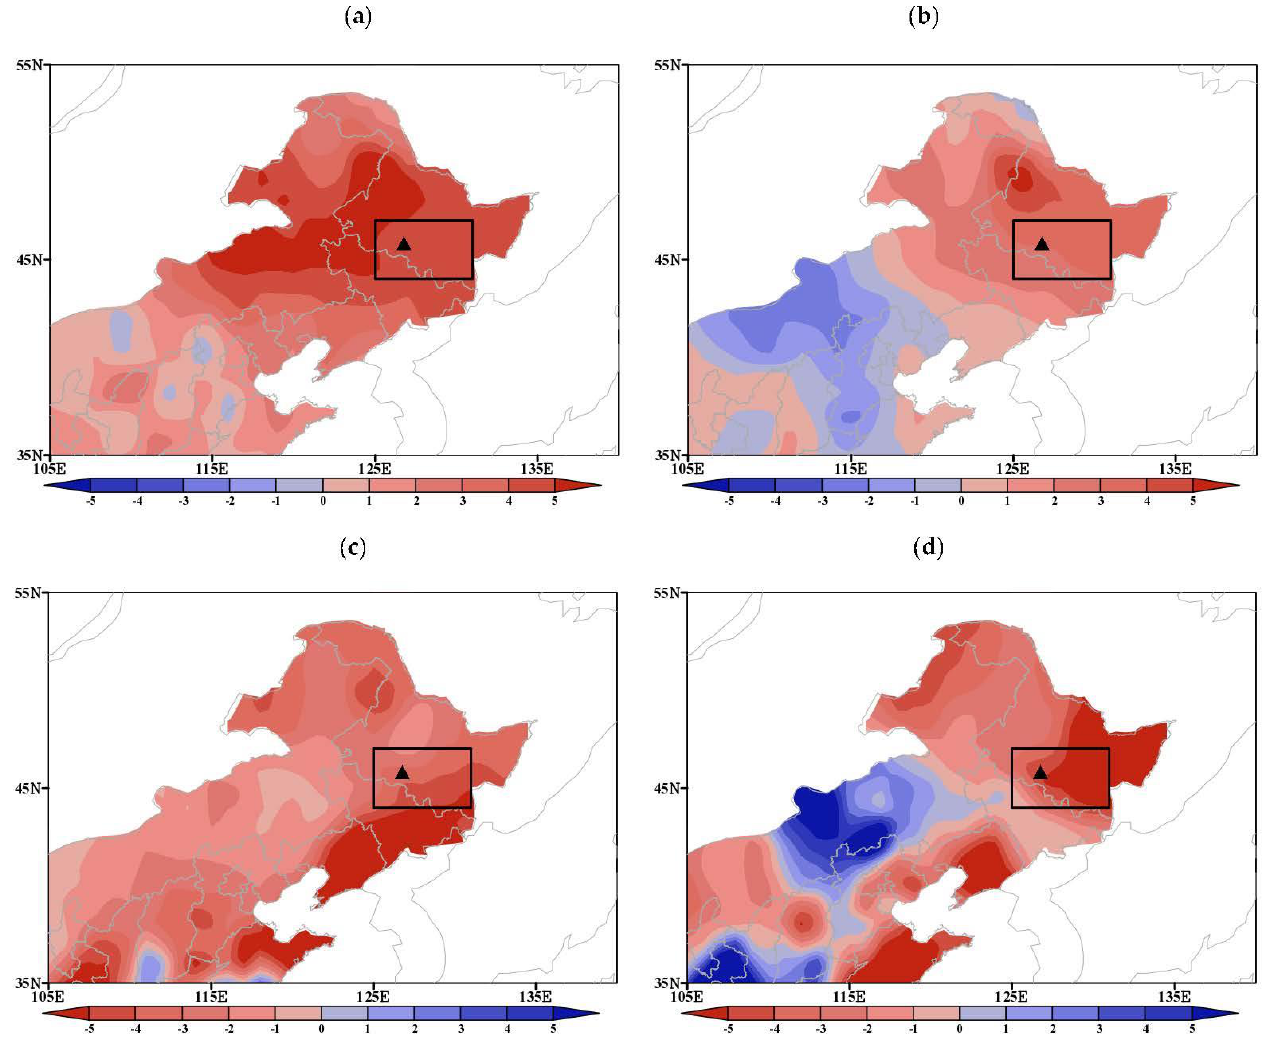
Figure 1. The temperature anomalies in ( a ) January and ( b ) February of 2019 (units: C), and the anomalies in precipitation in ( c ) January and ( d ) February of 2019 (units: mm). The climatic mean is for the 30 years of 1981 − 2010. The domain (125 − 131°E, 44 − 47°N) around Harbin is marked in black, and black triangle marks the location of Harbin Ice and Snow World.